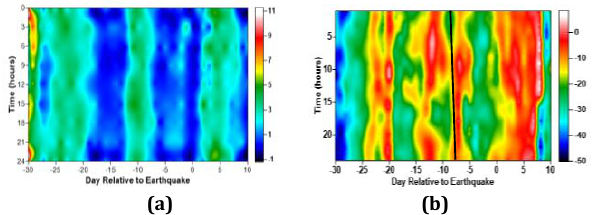
Figure 3: Results from analysis of geomagnetic indices (a) kp index and (b) Dst index. The y-axis represents universal time (UTC) while the x-axis shows the day relative to earthquake (13 th January, 2007). The black lines within the contour plot show the condition of the indices eight days prior to the event while the colour bar shows the ranges for different colours